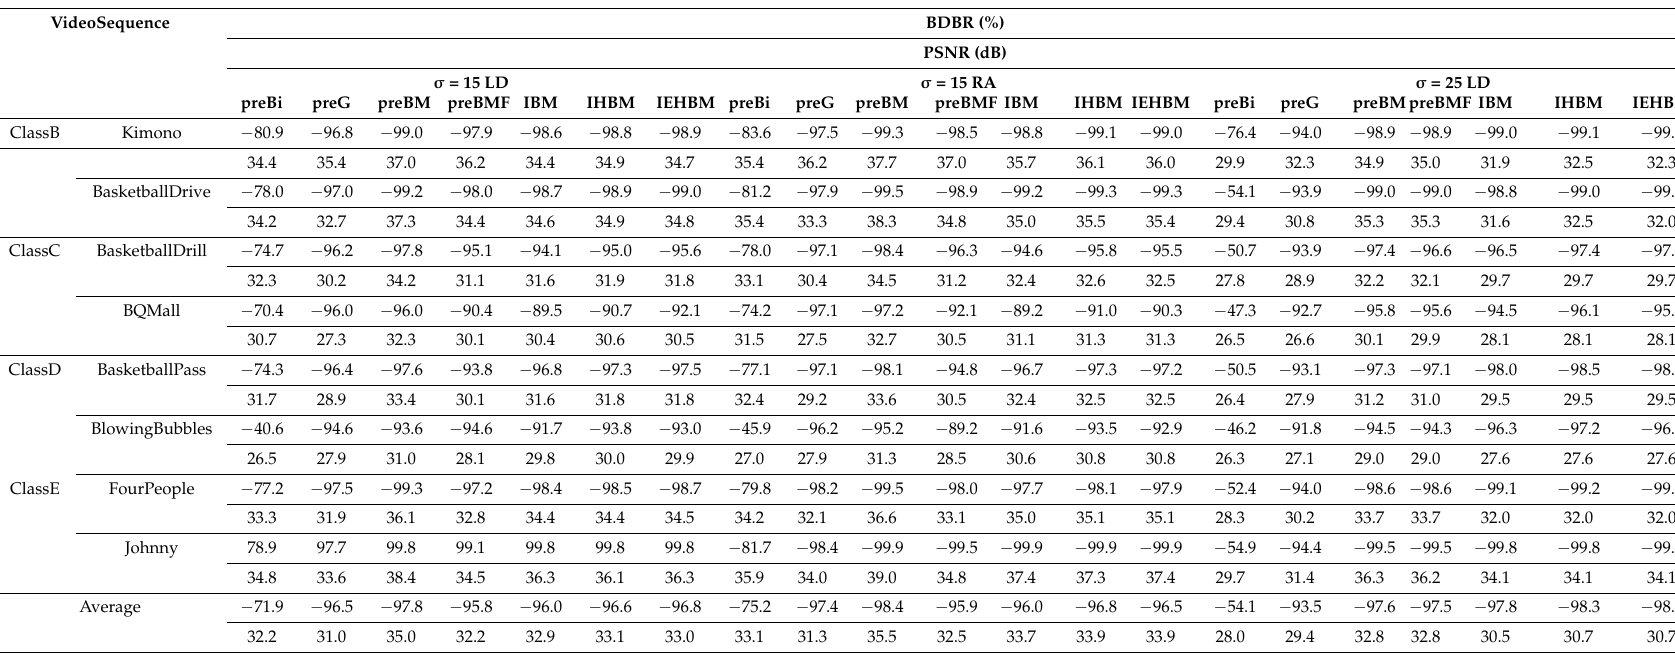
Table 2. Comparison of coding efficiency and denoising performance for noisy video sequences. BDBR: Bjøntegaard delta bit rate; PSNR: peak-signal-to-noise